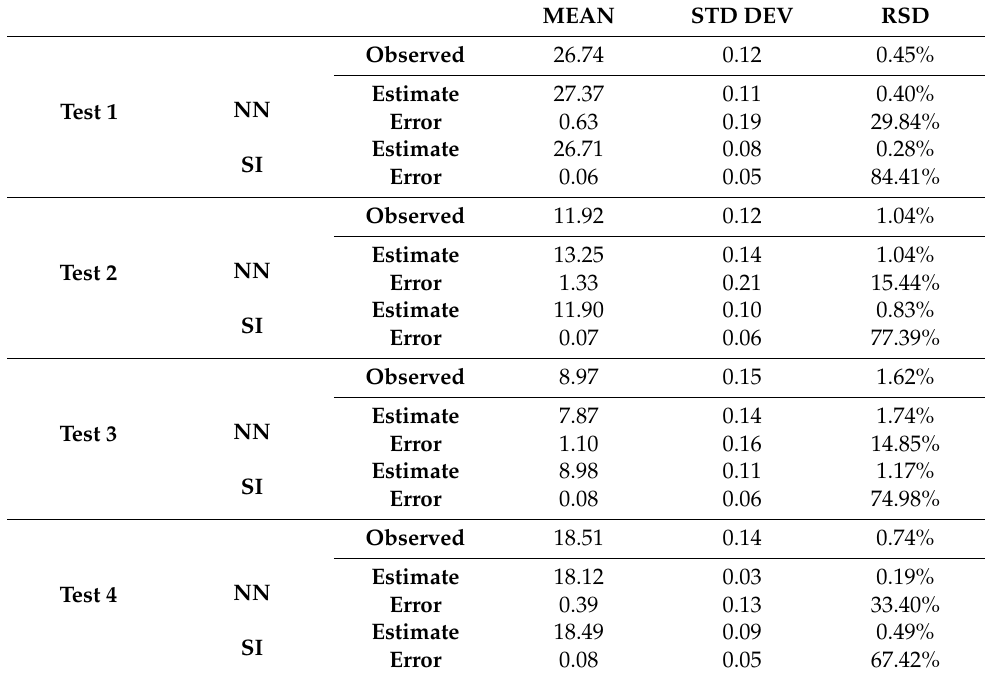
Table 8. Summary of the responses of the neural network models and Grey Wolf for the analyzed tests. MEAN STD DEV